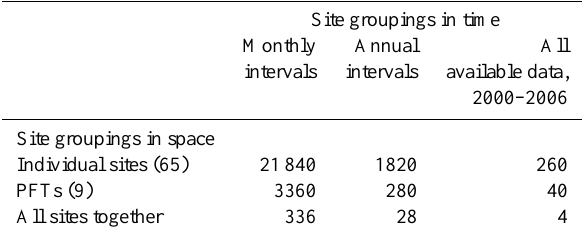
Table 2. Total number of parameters resulting from the nine differ- ent schemes used to group observation sites for VPRM parameter